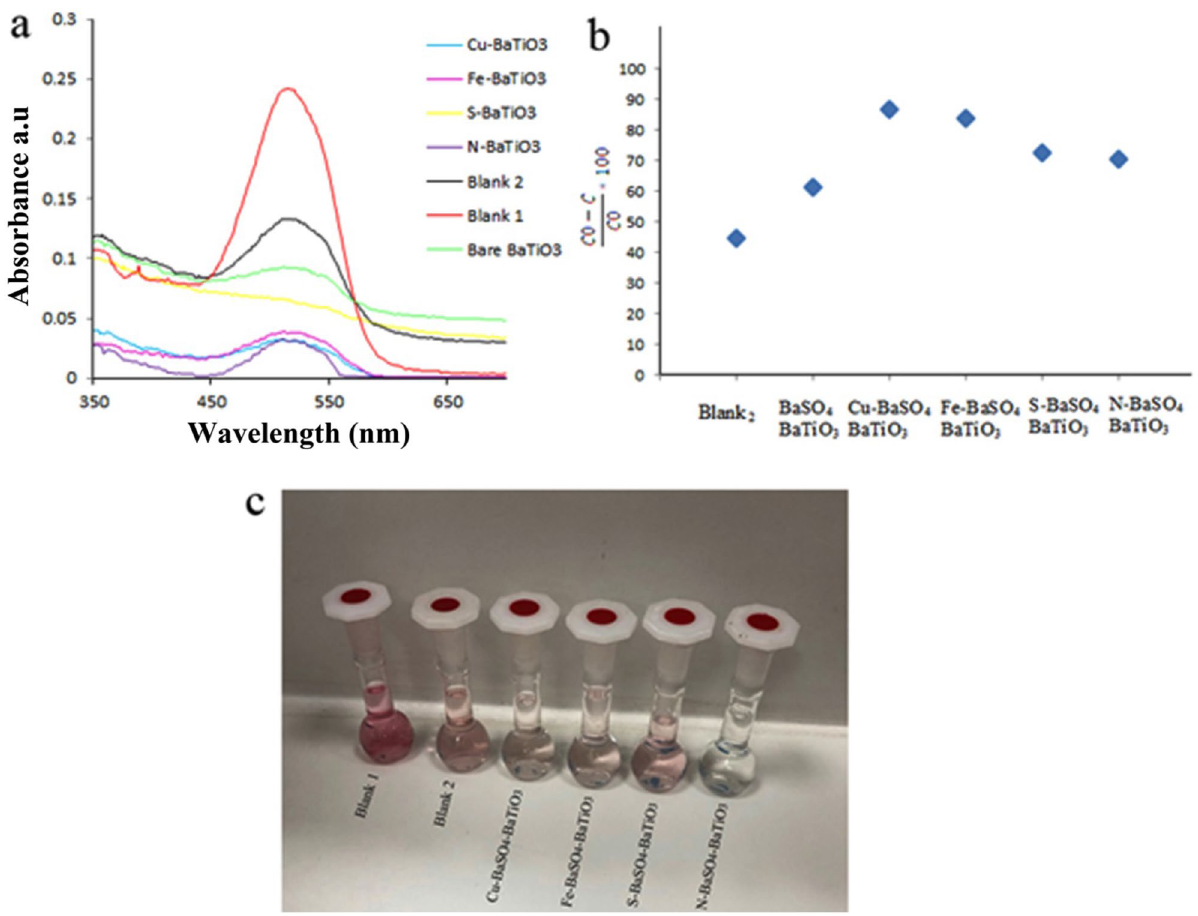
Figure 8. ( a ) The UV–Vis spectrum of initial AR151 (blank 1), AR151 after treat it with bare ultrasonic (blank 2), BaSO